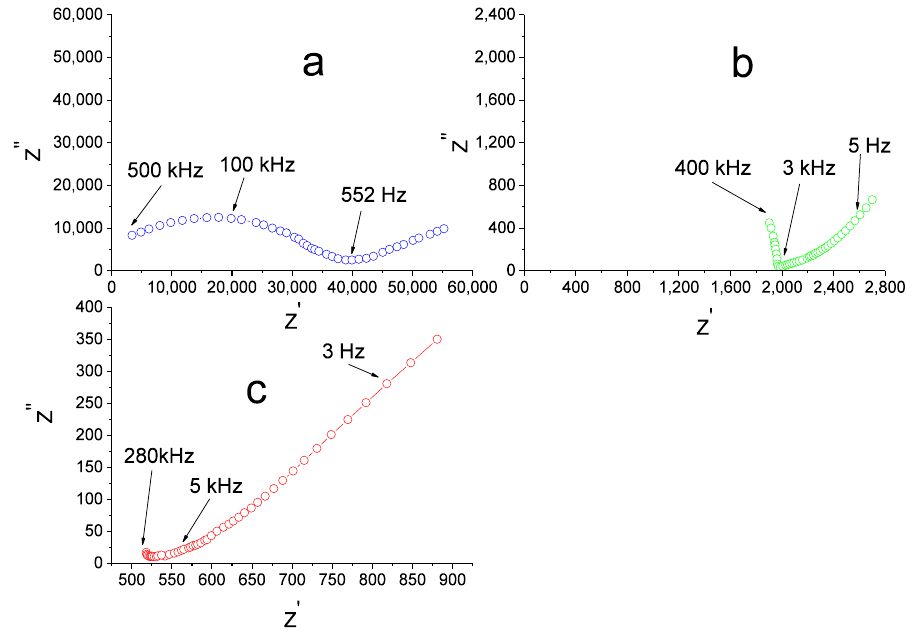
Figure 2. Impedance spectra of Ag|Li 5.95 Zr 1.95 Nb 0.05 O 7 |Ag cell at 225 ( a ), 400 ( b ), 550 ( c ).